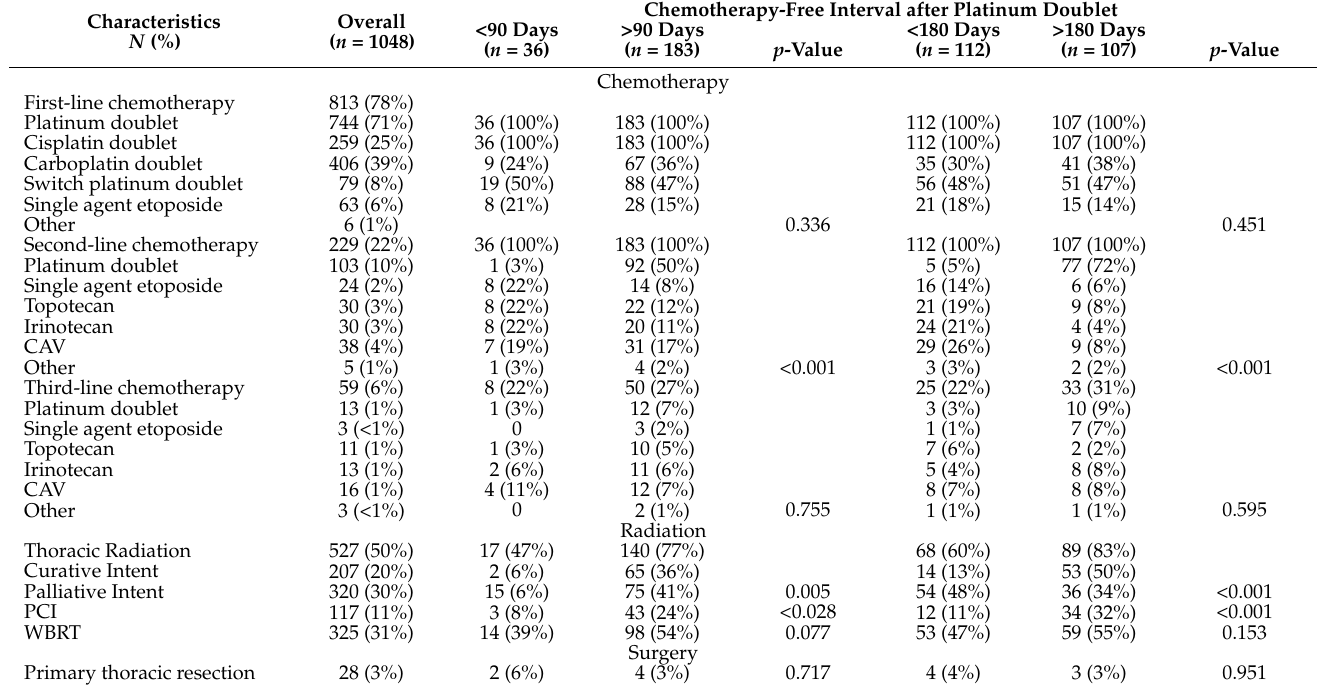
Table 2. Treatment received in full SCLC population and patients treated with first-line platinum doublet who received second-line systemic therapy based on chemotherapy-free interval.